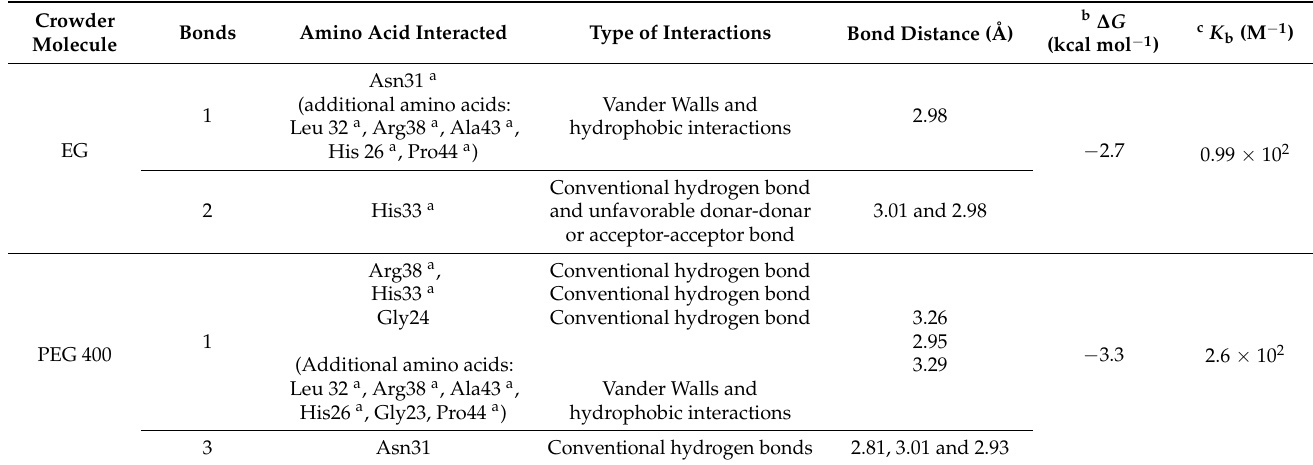
Table 3. Binding sites and various types of interactions occurring between crowders (EG and PEG 400) and cyt c